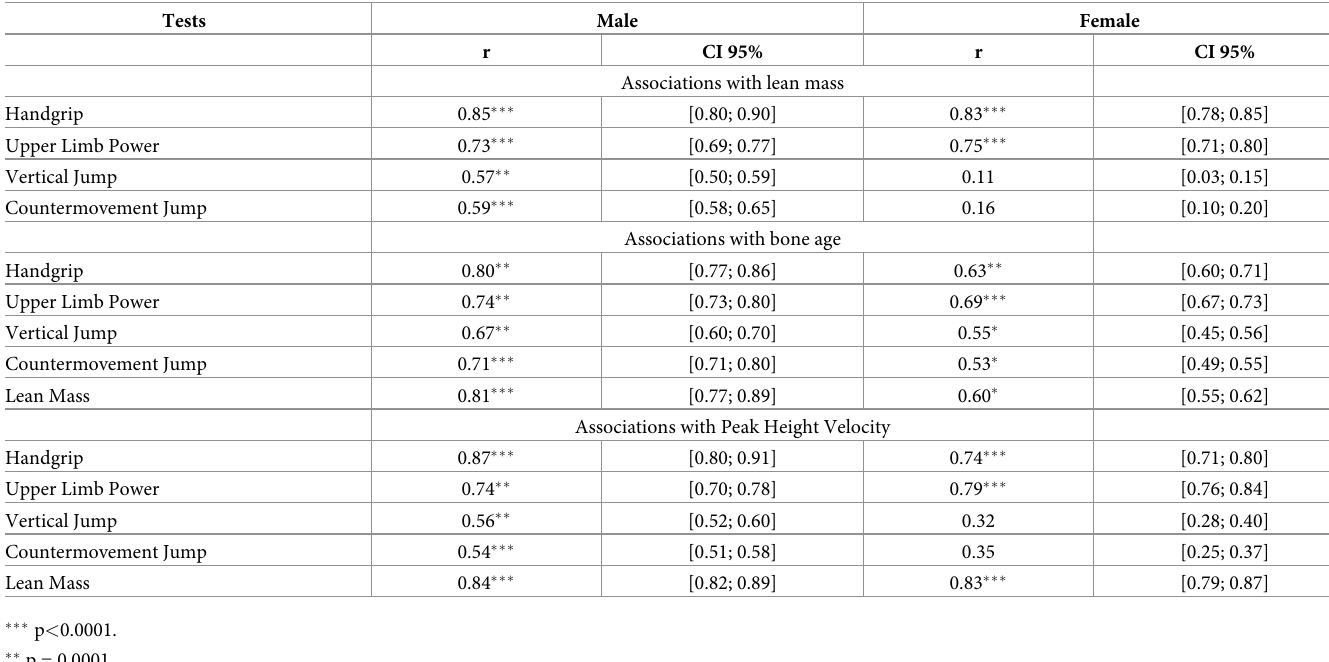
Table 2. Matrix of associations of the neuromuscular tests with lean mass, bone age and peak height velocity and of lean mass with bone age and peak height